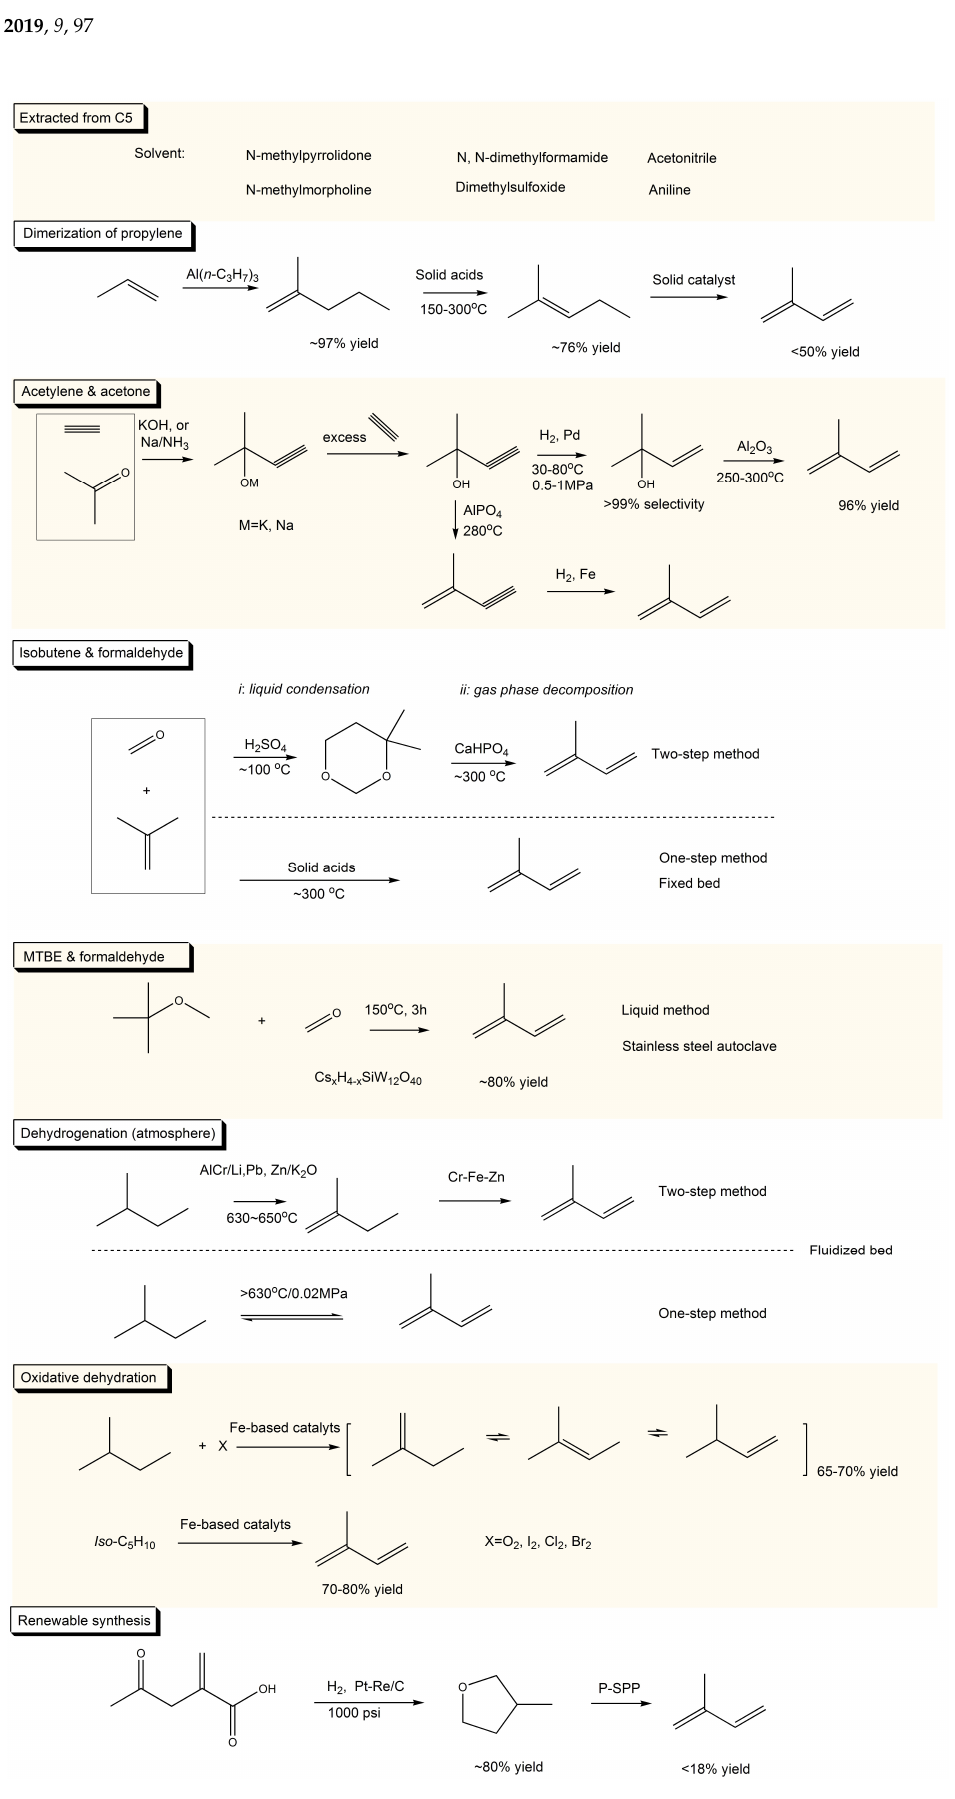
Figure 5. Overview of isoprene (IP) production routes